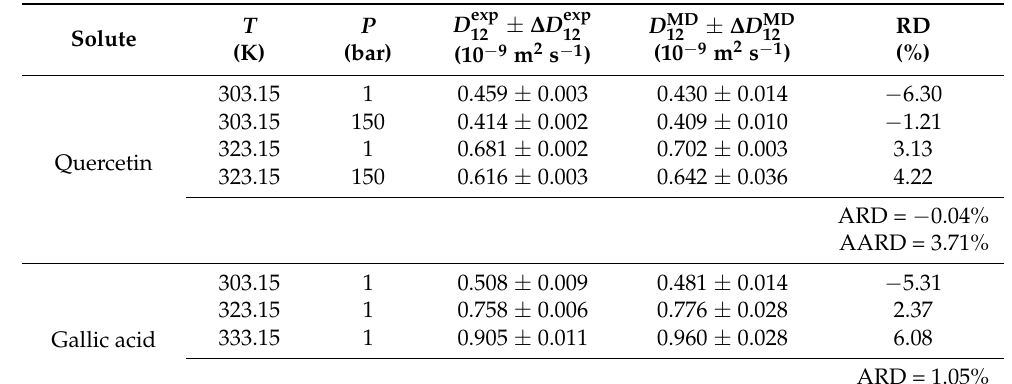
Table 1. Experimental ( D exp ) and computed ( D MD ) diffusion coefficients of quercetin and gallic 12 12 acid in liquid ethanol at various temperatures and pressures. The computer simulations used σ OH = 0.306 nm for ethanol, and the calculated diffusivities were evaluated in comparison with experimental data in terms of the relative deviation (RD), average relative deviation (ARD), and average absolute relative deviation